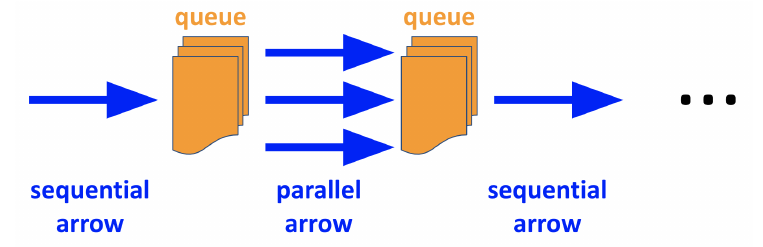
Figure 2. Visual representation of the arrow-queue design at the core of JANA2. Threads are assigned to arrows by the JANA system in a way that optimizes throughput based on the number of available threads. See text for